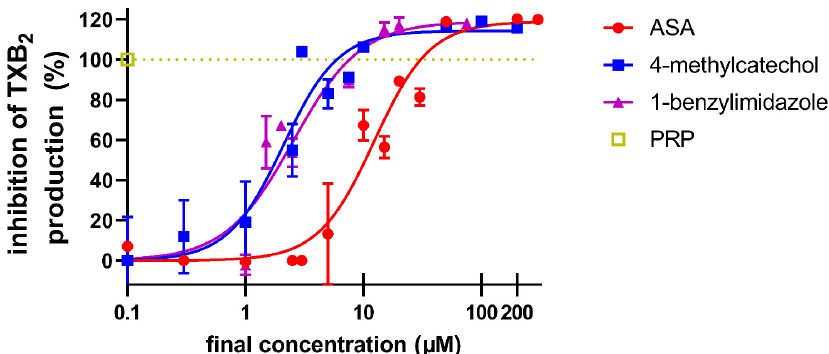
Figure 6. The effect of the tested compounds on the synthesis of thromboxane A 2 from arachidonic acid. Platelet-rich plasma (PRP) treated with thromboxane receptor antagonist terutroban at a final concentration of 2 μ M in order to hinder the activation of platelet aggregation was incubated with the tested compounds for 3 min. The reaction was initiated by adding arachidonic acid (AA) at a final concentration of 100 μ M and terminated after 7 min by adding a cold ethylenediaminetetraacetic acid disodium salt solution at a final concentration of 1 mM. PRP—a blank sample treated under the same conditions without the addition of AA. TXB 2 —thromboxane B 2 .